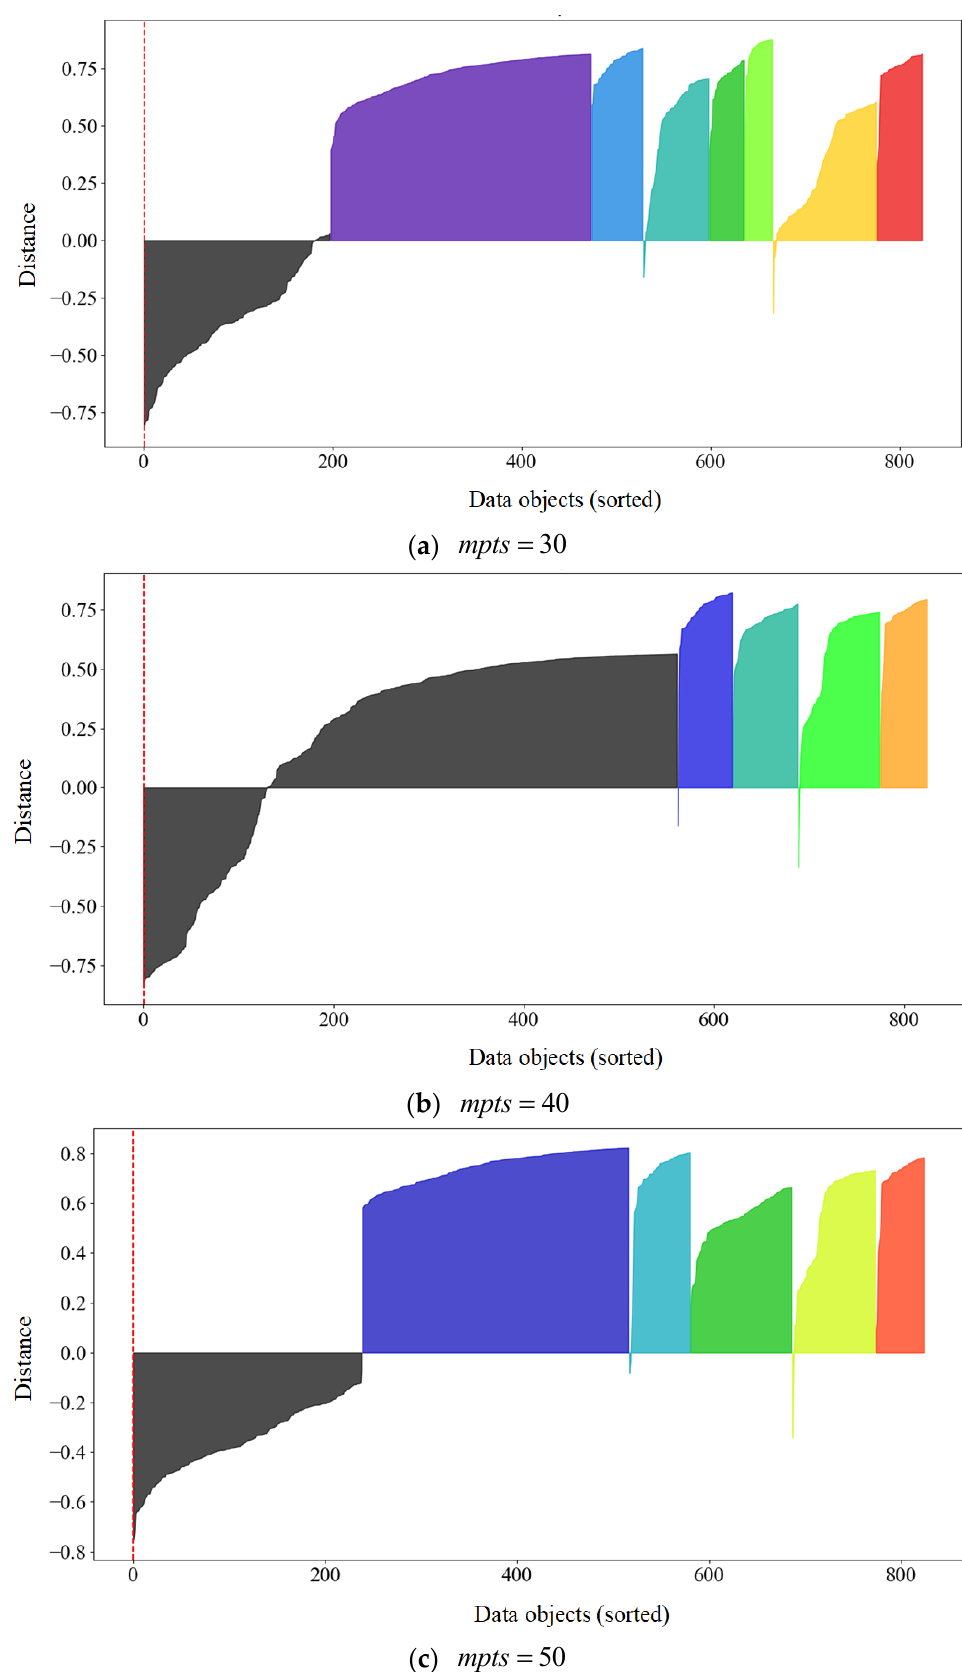
Figure 7. Silhouette plots based on “PDIA-SL” dataset.